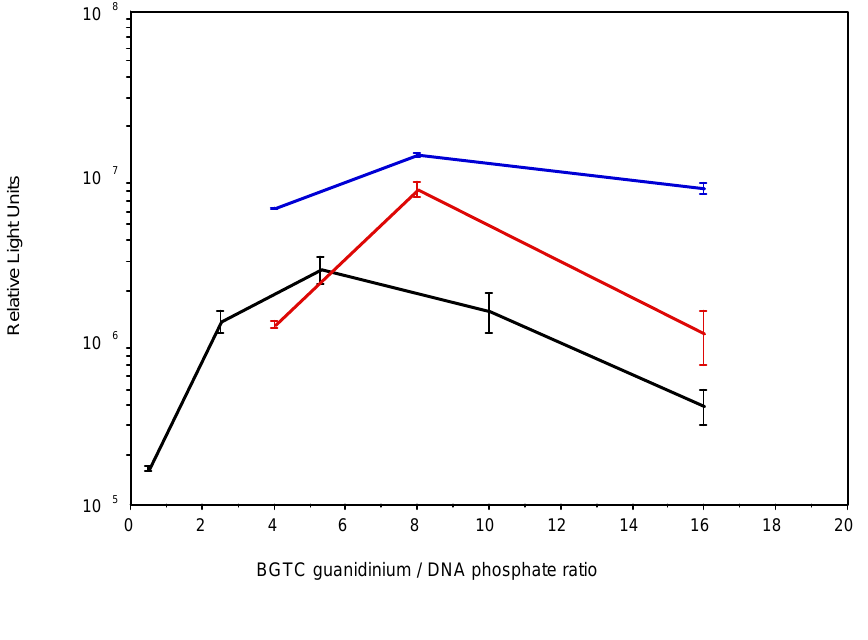
Figure 18. Luciferase reporter gene expression as a function of the mean charge of the lipid/DNA ag-